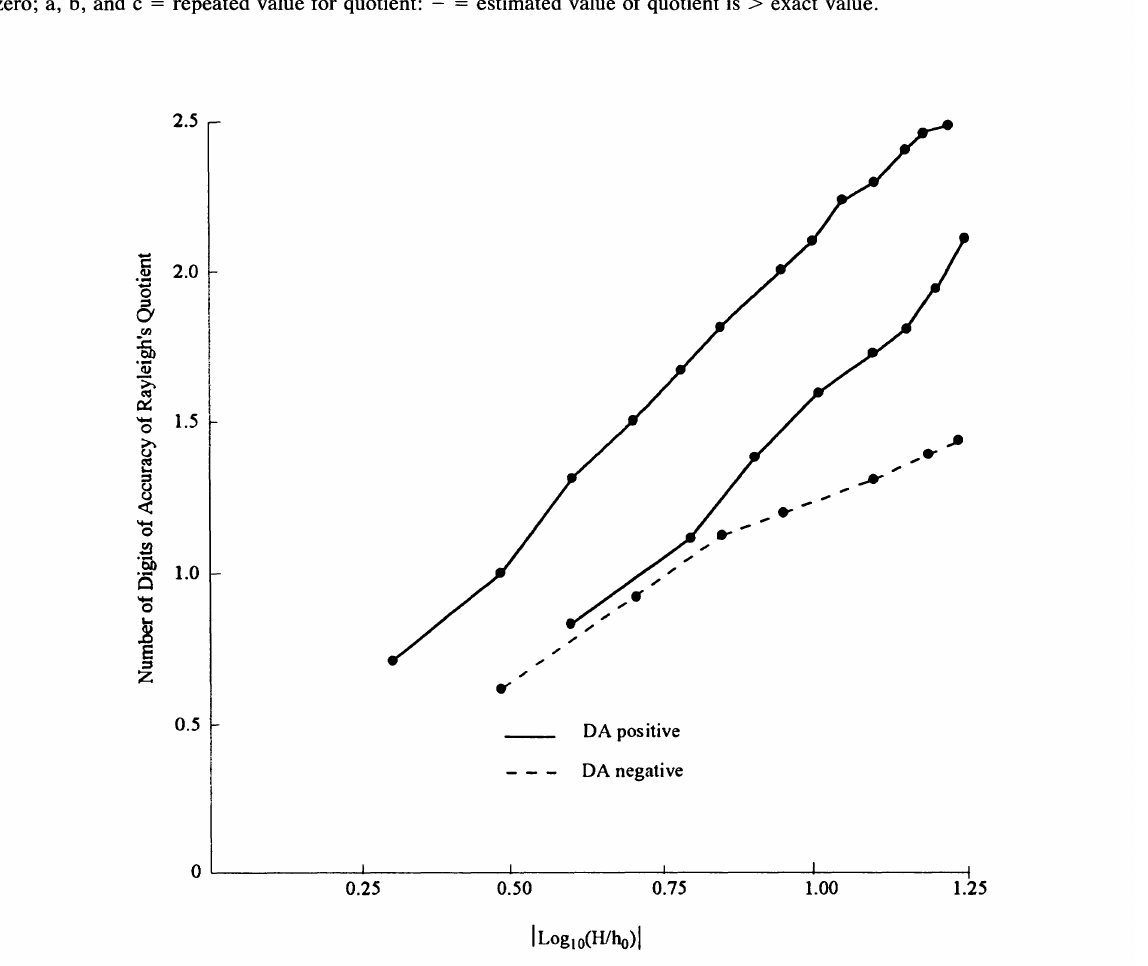
FIGURE 3 Convergence curves for vibrating